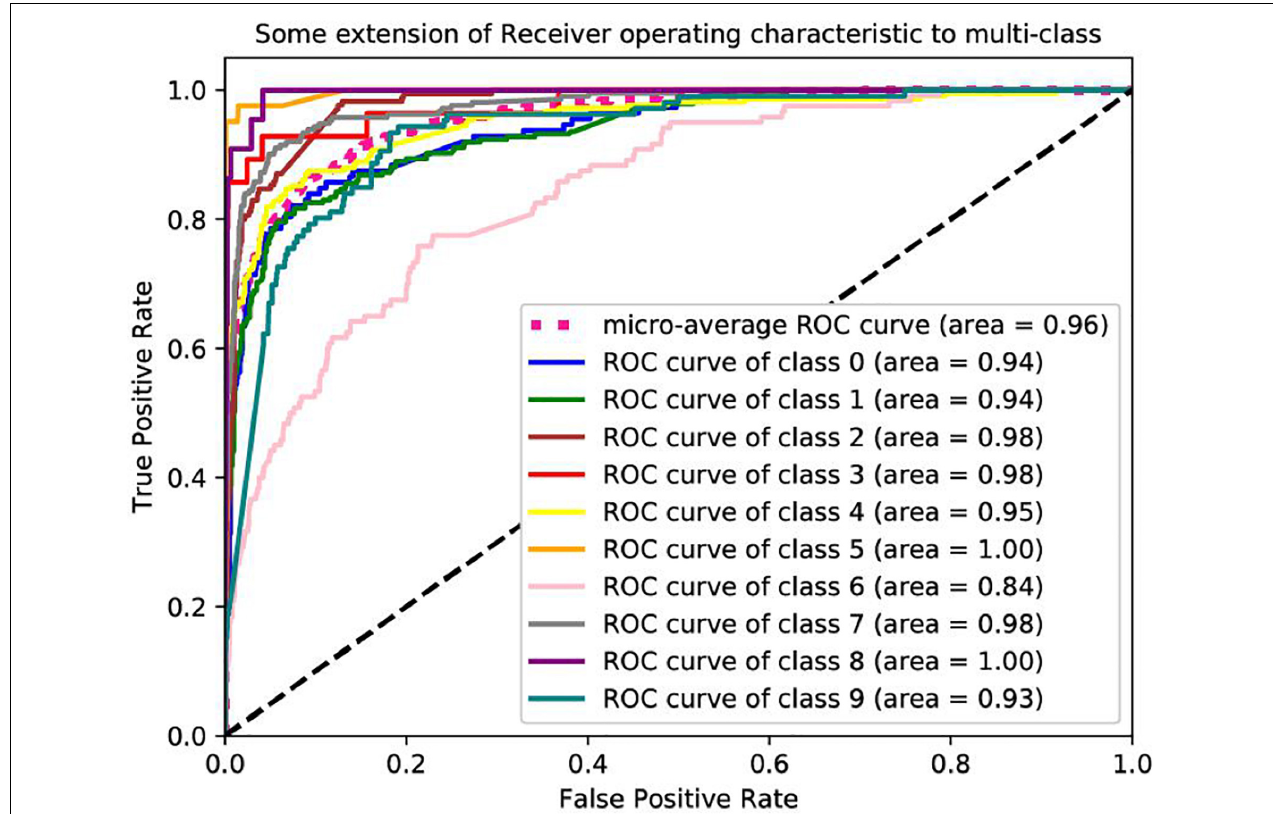
FIGURE 4 | Receiver operating characteristic to predict the tissue of origin of